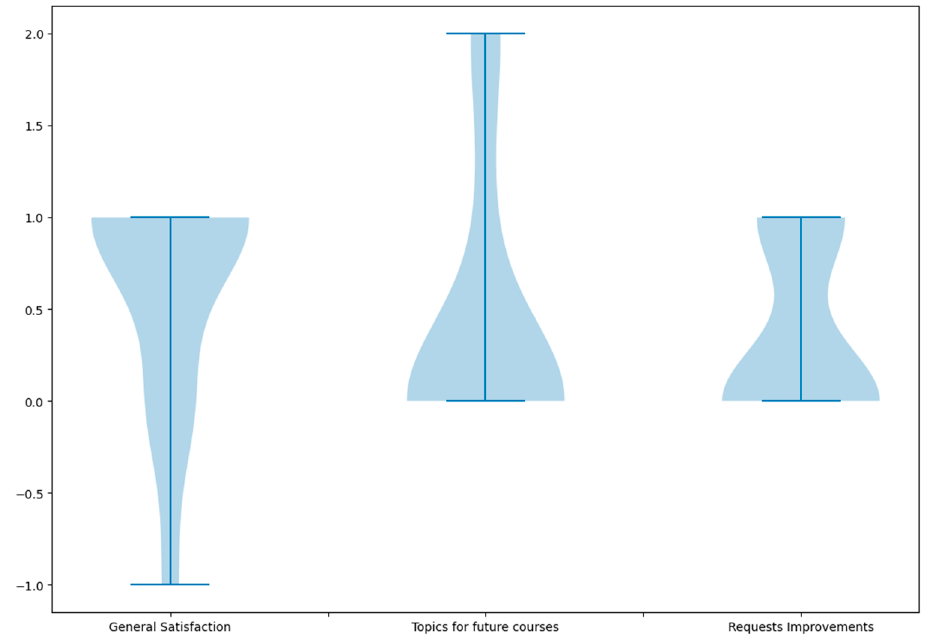
Figure 6. Quantitative interpretation of participant’s answers to open-ended Question #5—“Comments and/or suggestions”.